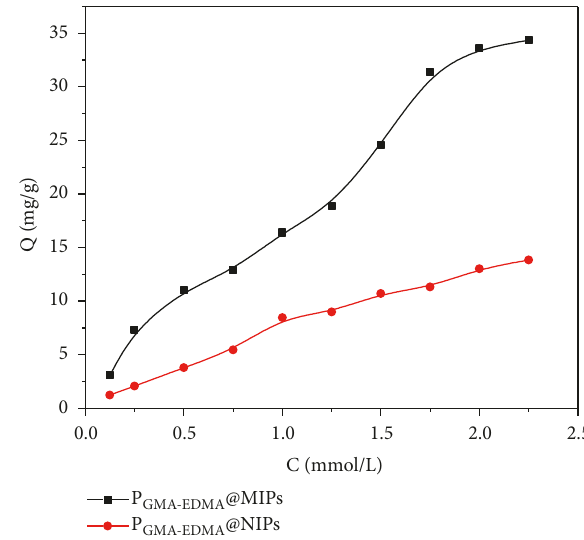
Figure 6: Dynamic adsorption curves of P GMA P GMA @NIPs. - EDMA